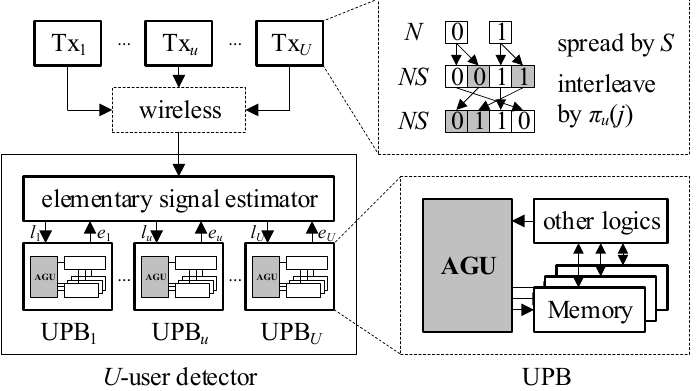
Figure 1. Interleave division multiple access (IDMA) system and U -user detector architecture.